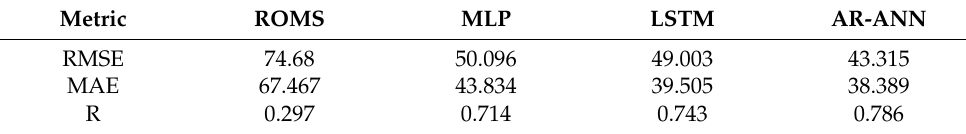
Table 3. Error metric for tidal current